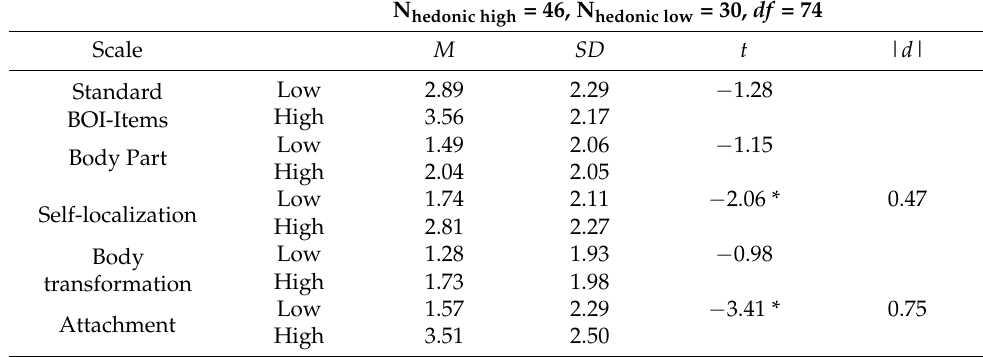
Table 3. Results of the evaluation of H3 comparing smartphone perceived as hedonic high versus low. T -Test comparing smartphone perceived as hedonic high with smartphone perceived as hedonic low for significant mean differences, one-tailed. * Significant at p < 0.05, one-tailed.M in cm, SD in cm. t = t -value, df = degrees of freedom, |d| = effect size Cohen’s d. Smartphone Hedonic High versus Smartphone Hedonic Low